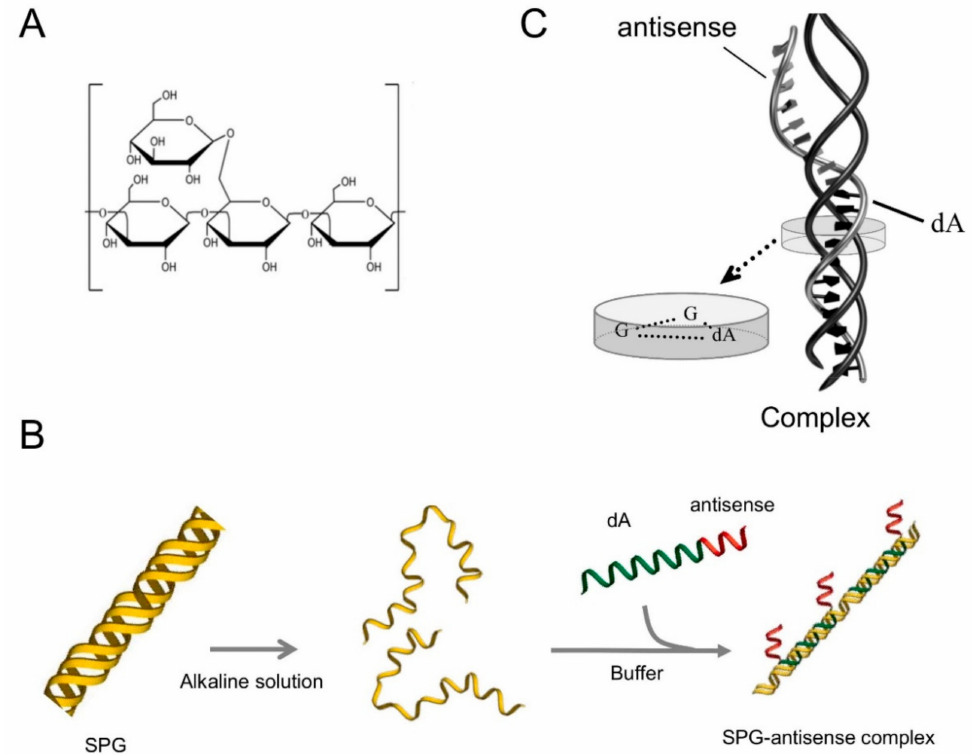
Figure 1. Schematic illustration showing a complex structure composed of antisense oligonucleotides (ASOs) with a dA tail and schizophyllan (SPG). ( A ) Chemical structure of SPG. ( B ) Schematic illustration of the SPG–ASO complex. ( C ) A triple-stranded complex was formed from one DNA and two SPG